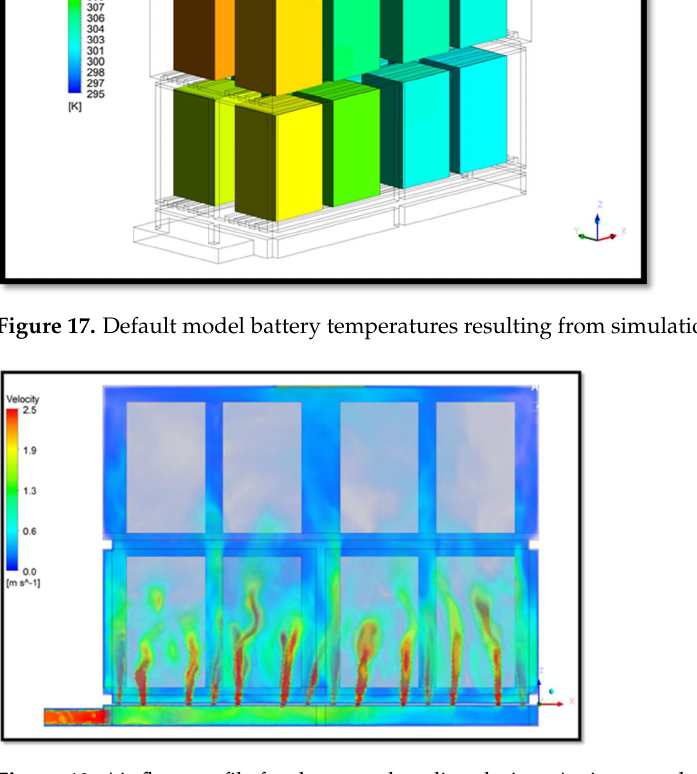
Figure 19. Vented model battery temperatures resulting from simulation. The model employing vortex generators, shown in Figure 20, experienced a decrease in temperature for nearly each battery in comparison to the default model. The most dramatic temperature reductions were for batteries 9 and 13 on the top rack, with each battery experiencing approximately 5 °C decrease in temperature. The battery temperatures are shown in Figure 22. The disruption of flow caused by Vortex Generators was believed to have improved the air flow distribution within the enclosure. This can be seen in Figure 21, where the flow disruption of a vortex generator mounted to the bottom of the rack is shown.